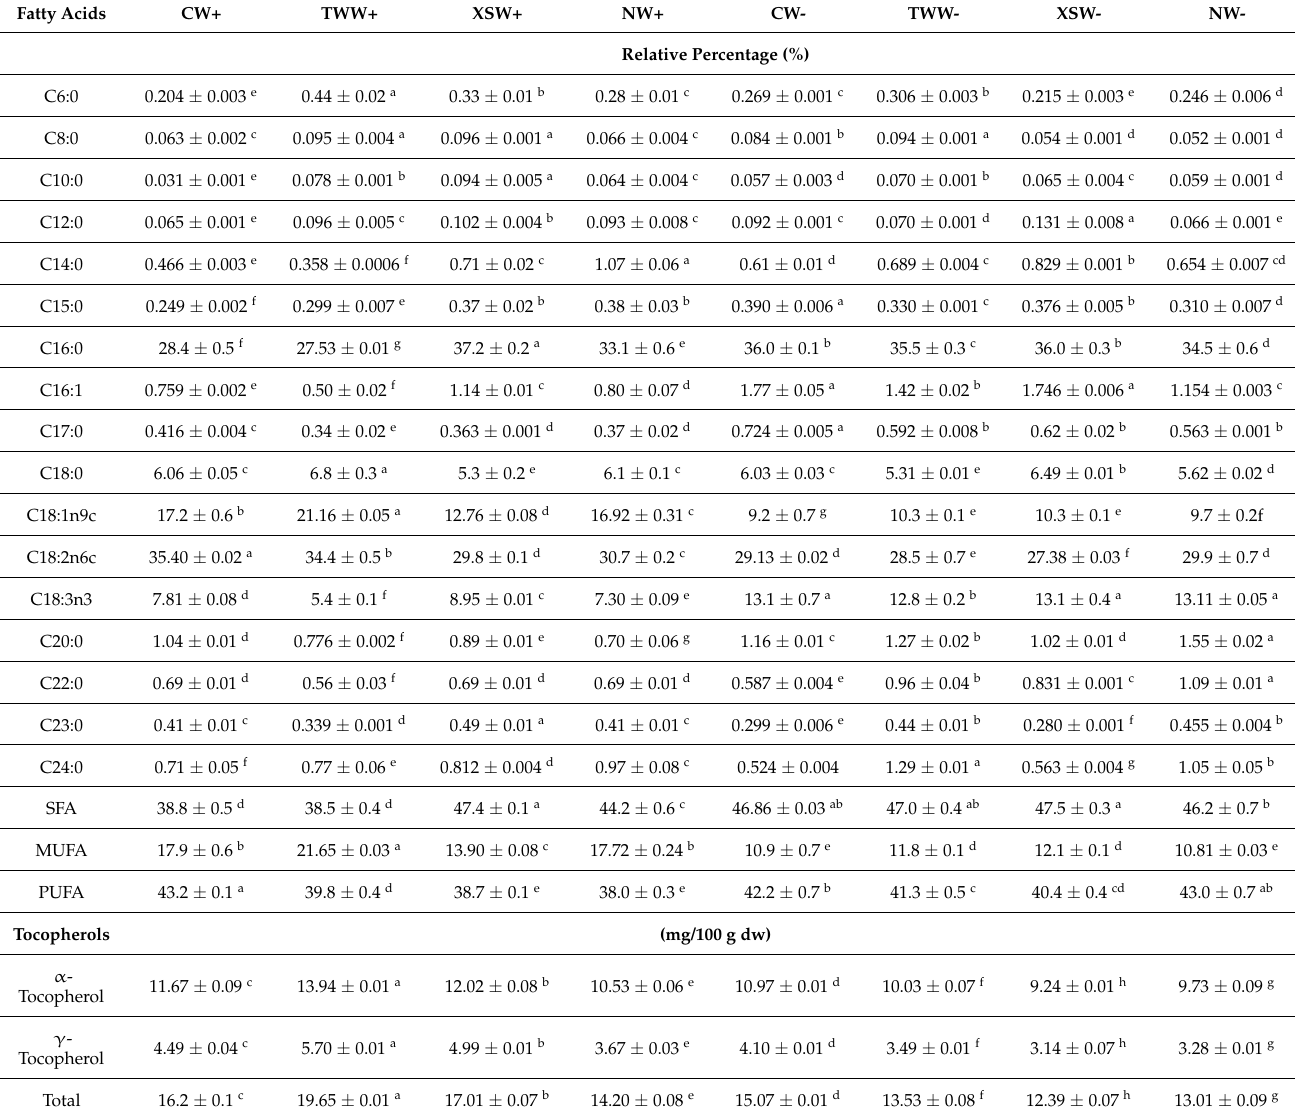
Table 2. Chemical composition with regard to lipophilic compounds (fatty acids and tocopherols) of tomato fruit in relation to irrigation regime and biostimulant treatment (mean ± SD, n =